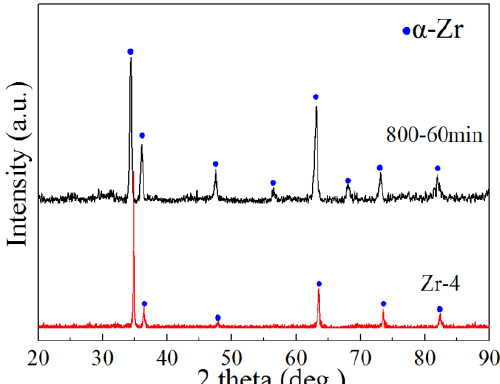
Figure 5. The microscopic metallographic and SEM images of the joints diffusion bonded at 800 °C/7 MPa: ( a , d ) 30 min, ( b , e ) 60 min, and ( c , f ) 90 min.